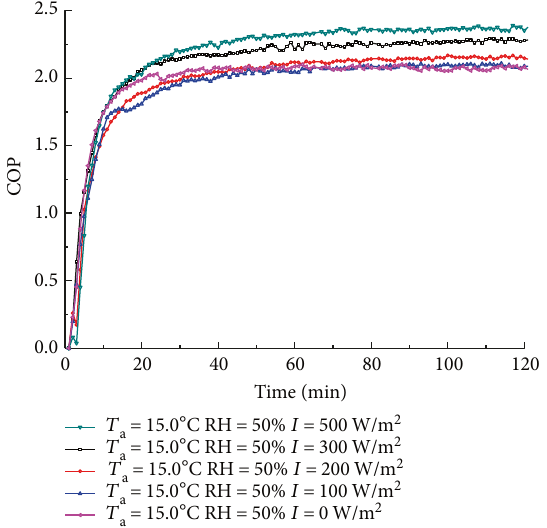
Figure 5: Variation of the energy consumption with solar